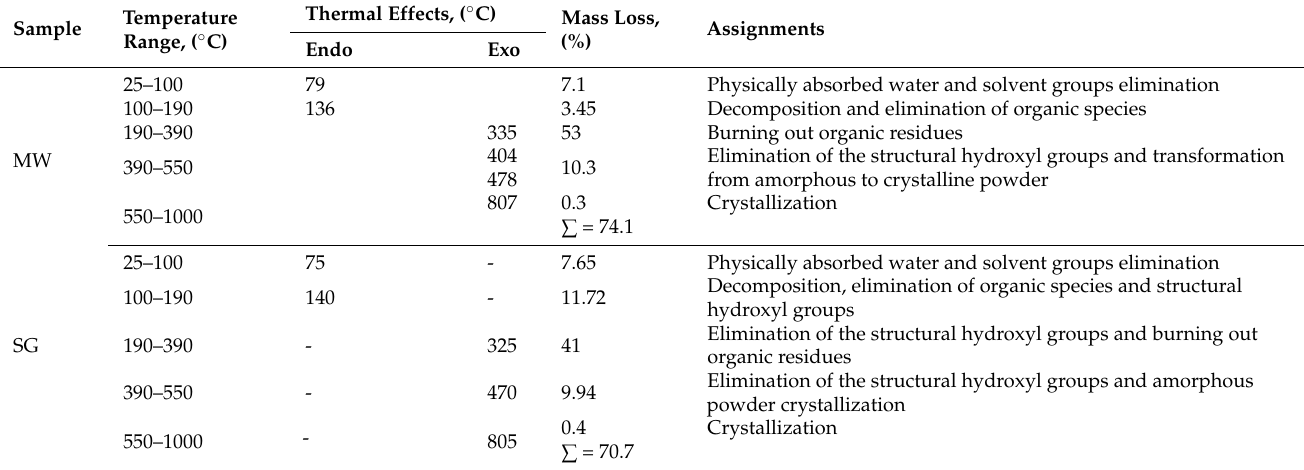
Table 1. The TGA/DTA results for the V doped ZnO gels.